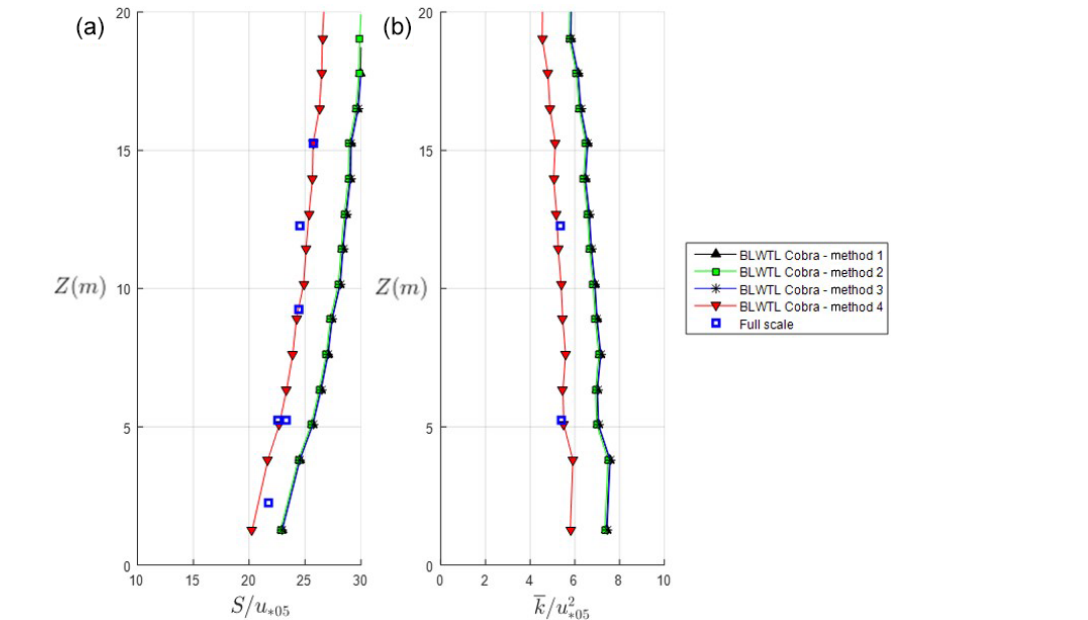
Figure 6. BLWTL inflow profiles of (a) mean flow speed and (b) TKE, normalized by friction velocity obtained using four different methods.